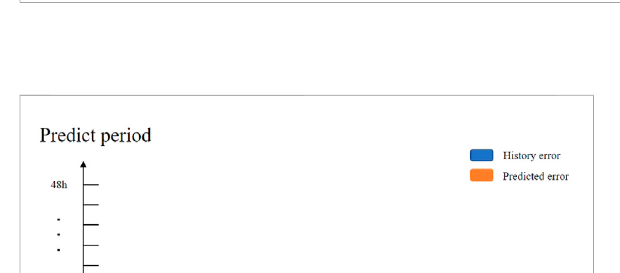
FIGURE 1 NWP prediction error of one location.